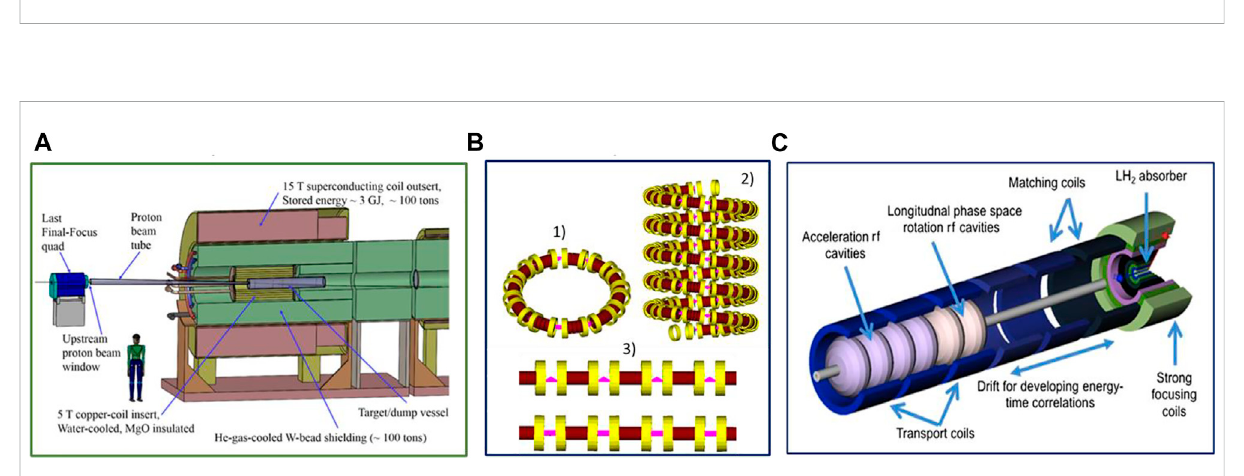
FIGURE 7 Cross-sections of the two design options for the 12 T SPPC dipole based on IBS.